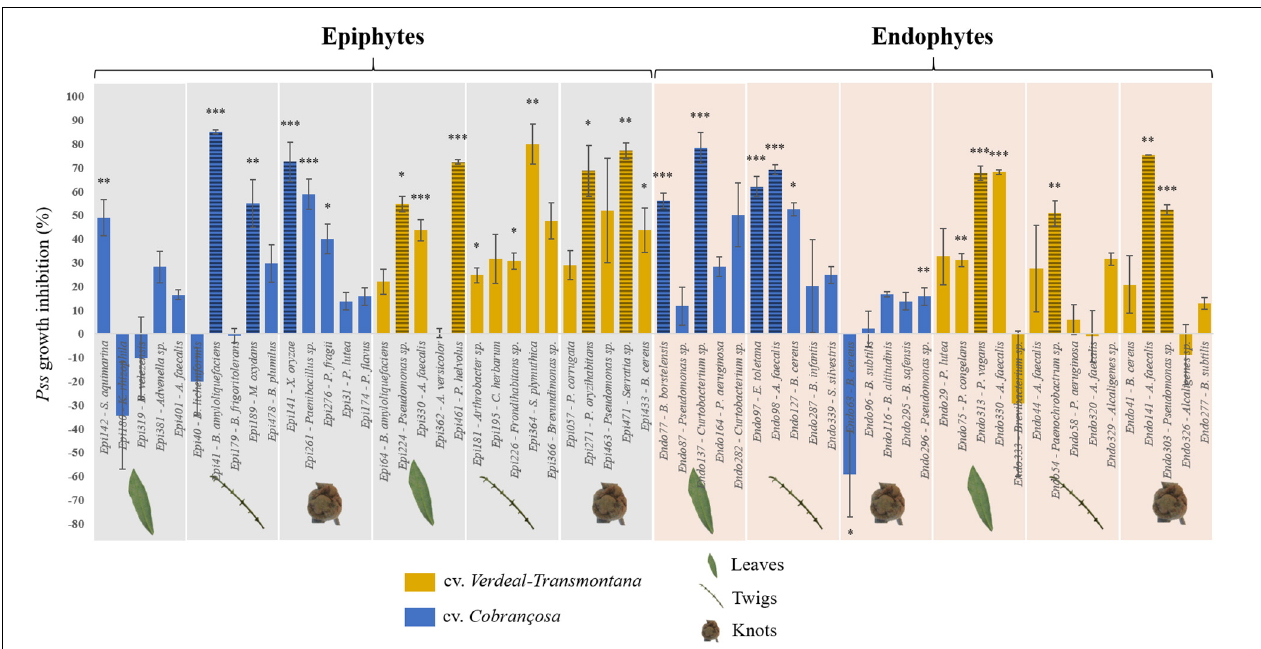
FIGURE 1 | Growth inhibition of Pseudomonas savastanoi pv. savastanoi ( Pss ) after interacting with different epiphytic and endophytic bacterial isolates, obtained from leaves, twigs and knots of olive tree cvs. Cobrançosa and Verdeal Transmontana . Results are presented as the percentage of inhibition in dual-culture assays considering single inoculated controls. Horizontal lines indicate the bacterial species further used for evaluating the inhibition mechanisms. Significant differences to control ( Pss single culture) are indicated by asterisks (* p < 0.05; ** p < 0.01; *** p <